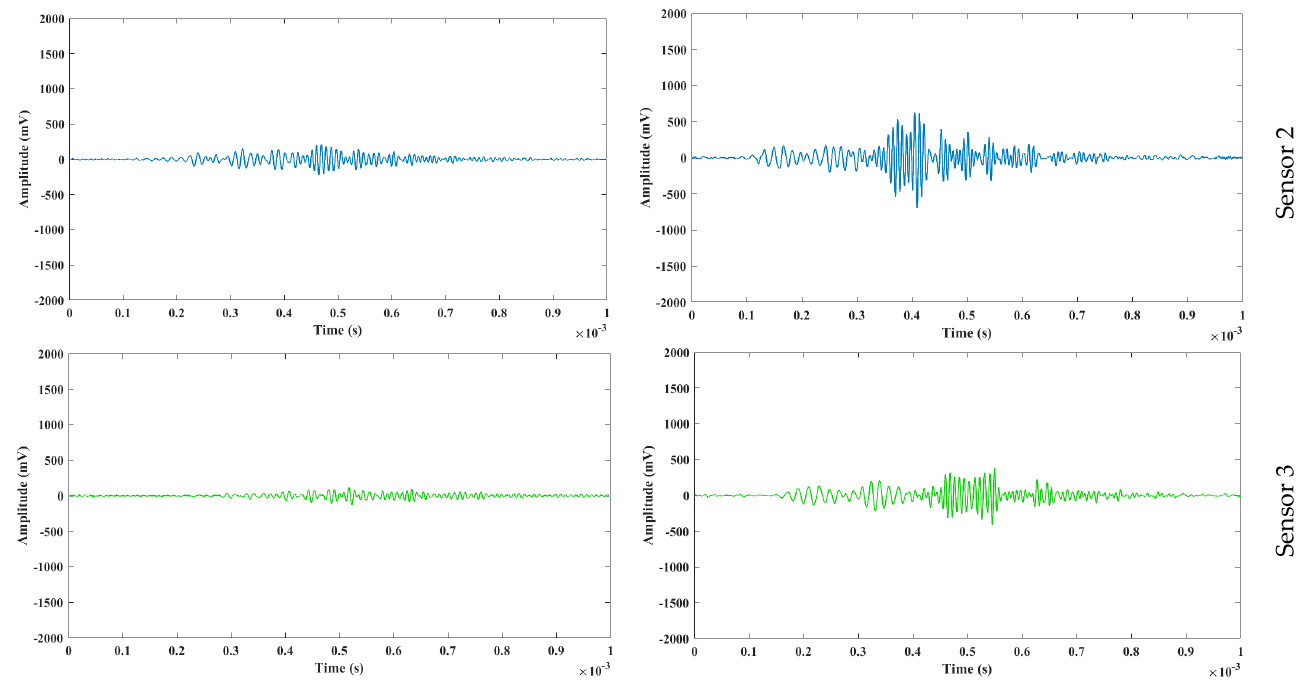
Figure 4. Time domain response graphs for parts with 60% and 100% infill.